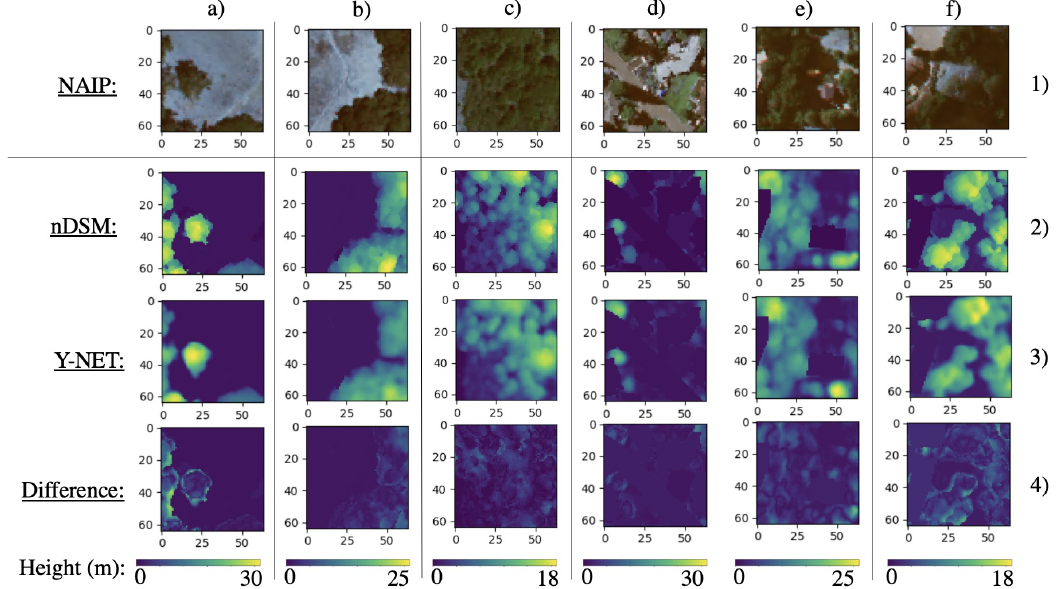
Figure 8. Visualization of Y-NET’s output for tiles. Each color bar only pertains to rows 2–4 of a column. The column labels a–f are used with the row numbers to reference each